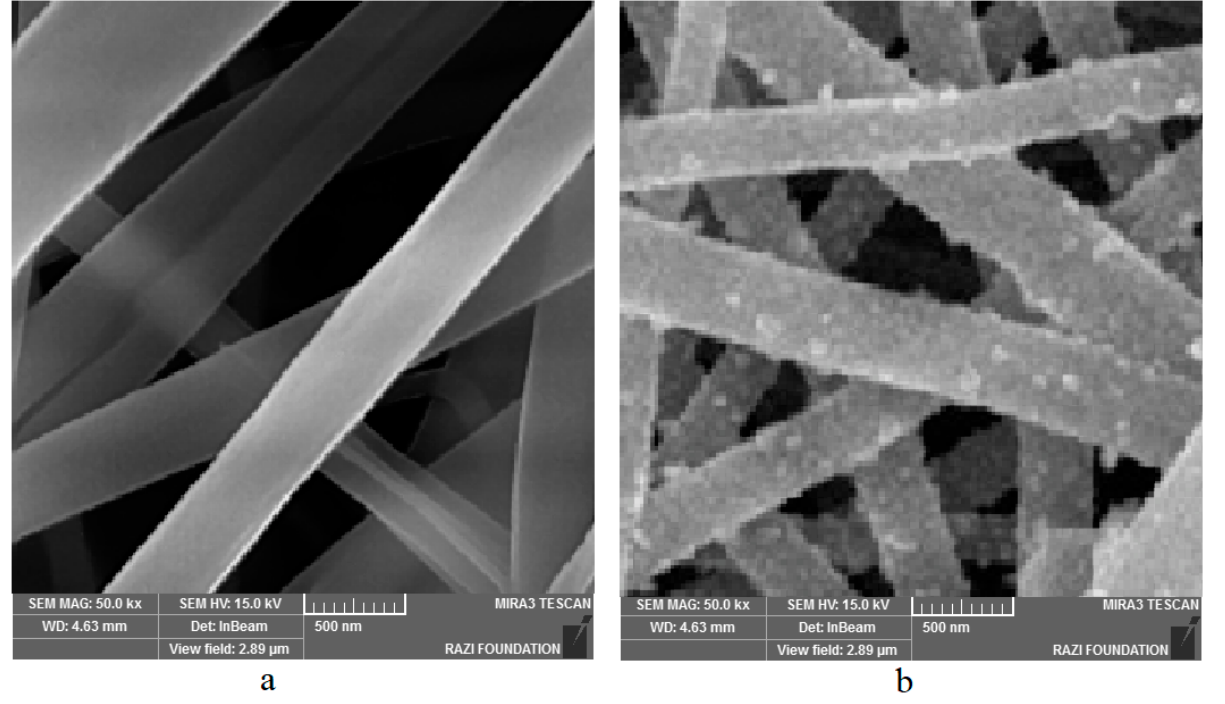
Figure 2. Images of scanning electron microscopy (SEM): gelatin–curcumin nanofibers ( a ) and hy- droxyapatite–gelatin/curcumin nanocomposites ( b ).